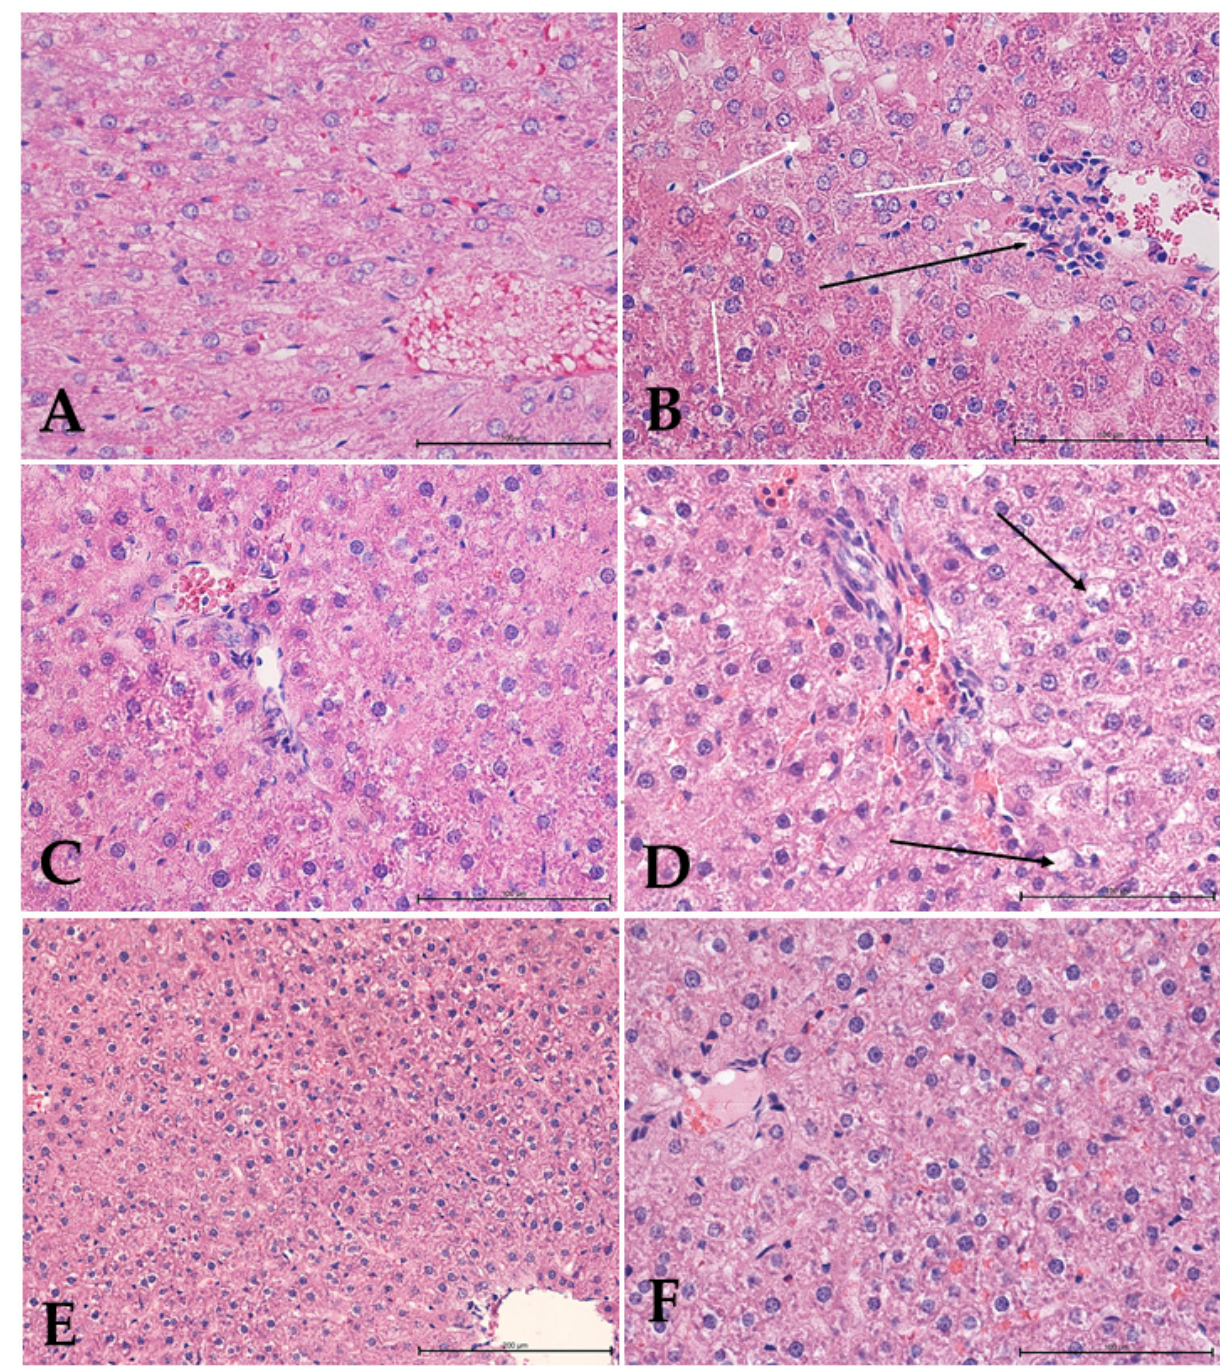
Figure 5. Histological examination of rat livers stained with hematoxylin and eosin (H&E). ( A ) Control group, showing liver tissue with normal architecture; ( B ) high-cholesterol group, showing hepatocytes with intracytoplasmic fat vacuoles (white arrows), small lymphatic infiltration around the liver vessels (black arrow) and numerous binuclear hepatocytes; ( C ) Ilex group, showing liver tissue with normal architecture; ( D ) terpenoids group, showing numerous hepatocytes with changes within the cytoplasm (black arrows); ( E , F ) high-cholesterol with terpenoids group, showing normal liver structure with increased content of fat droplets in hepatocytes. Mag. 400×. Bar scale 100 µm ( A – D , F ); Mag. 200×. bar scale 200 µm ( E ) .